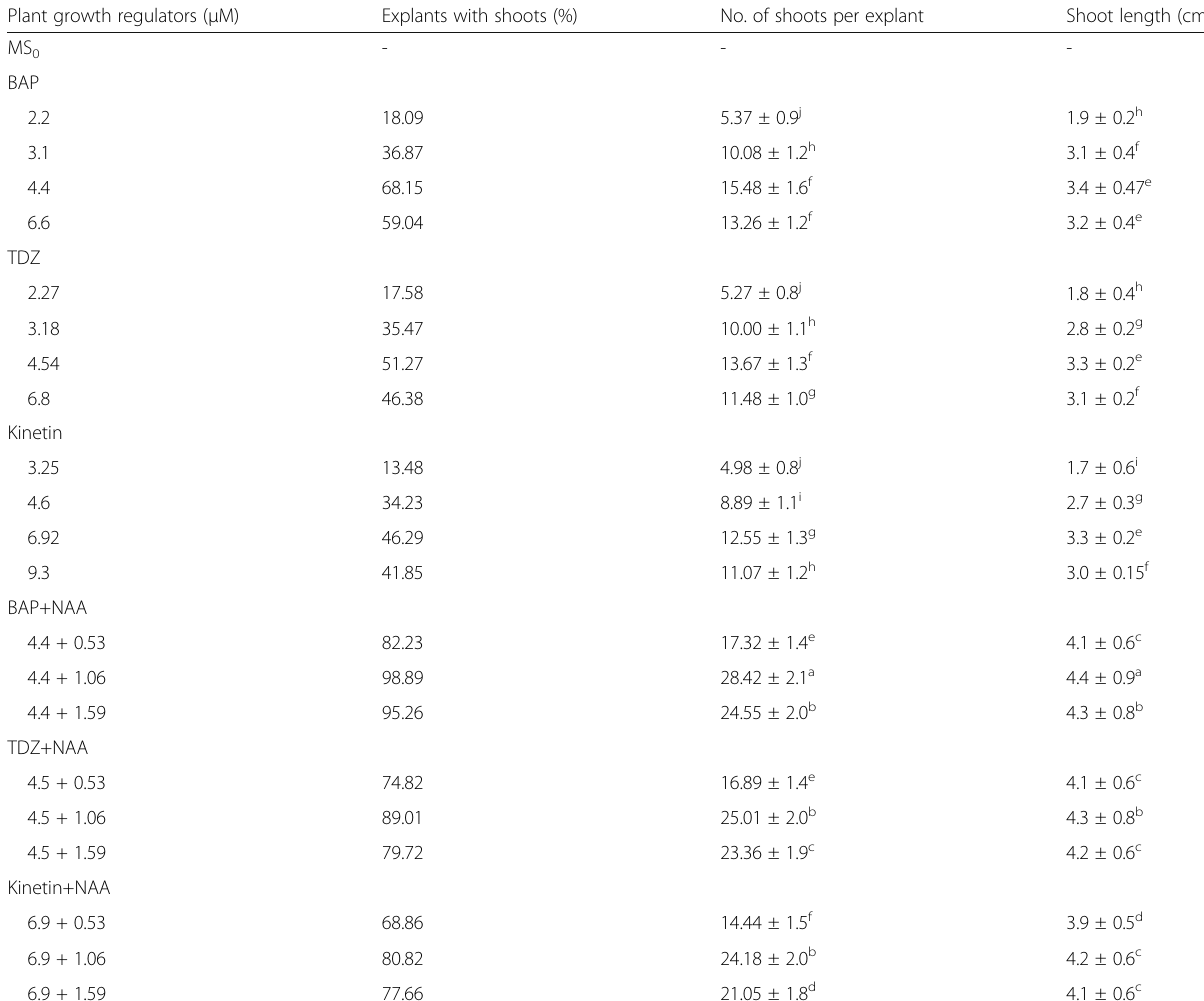
Table 1 Effect of cytokinins in combination with NAA on shoot proliferation from shoot tip explants of Tricholepis roylei inoculated in half-strength MS medium after 6 weeks of culture Plant growth regulators ( μ